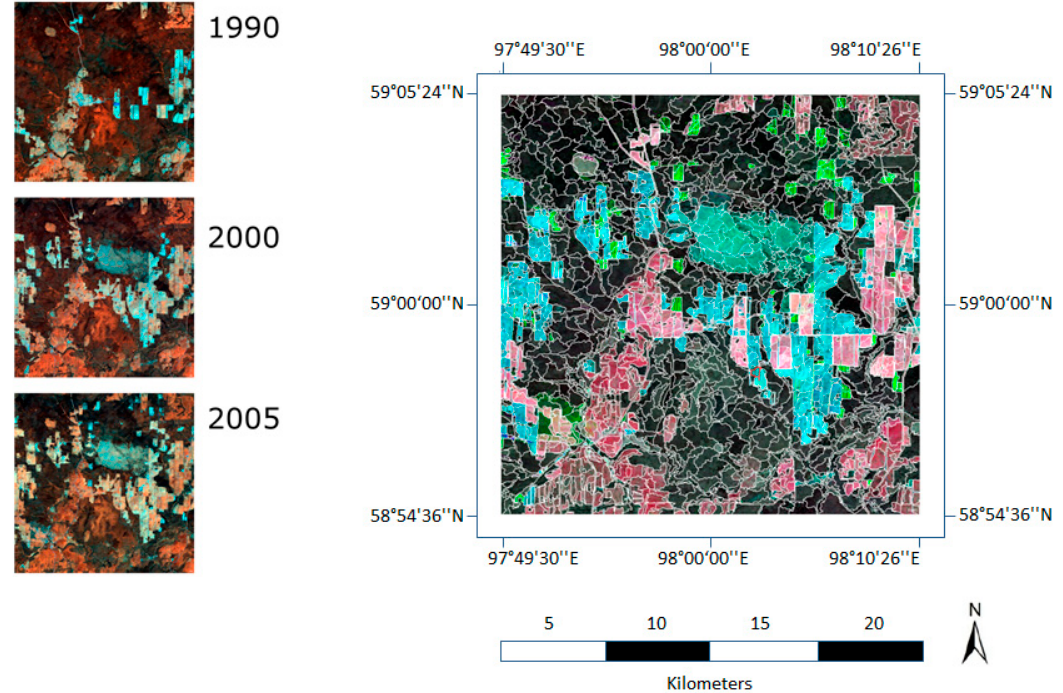
Figure 2. (From [1]) A multi-date segmentation for a 20 km × 20 km site in the boreal climatic domain. Landsat imagery from 1990, 2000, 2005 are combined into a single data stack and segmented. The segments (white outlines in image on right) capture areas of spectral similarity as well as areas of change over time. The Landsat image on the right is a colour composite of Landsat band 5 from 1990 (red), 2000 (blue) and 2005 (green). Changes in tree cover between time periods are evident.